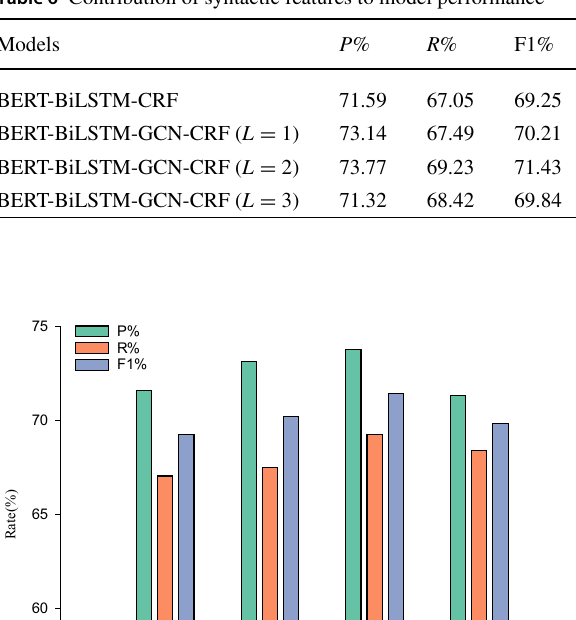
Contribution of syntactic features based on GCN